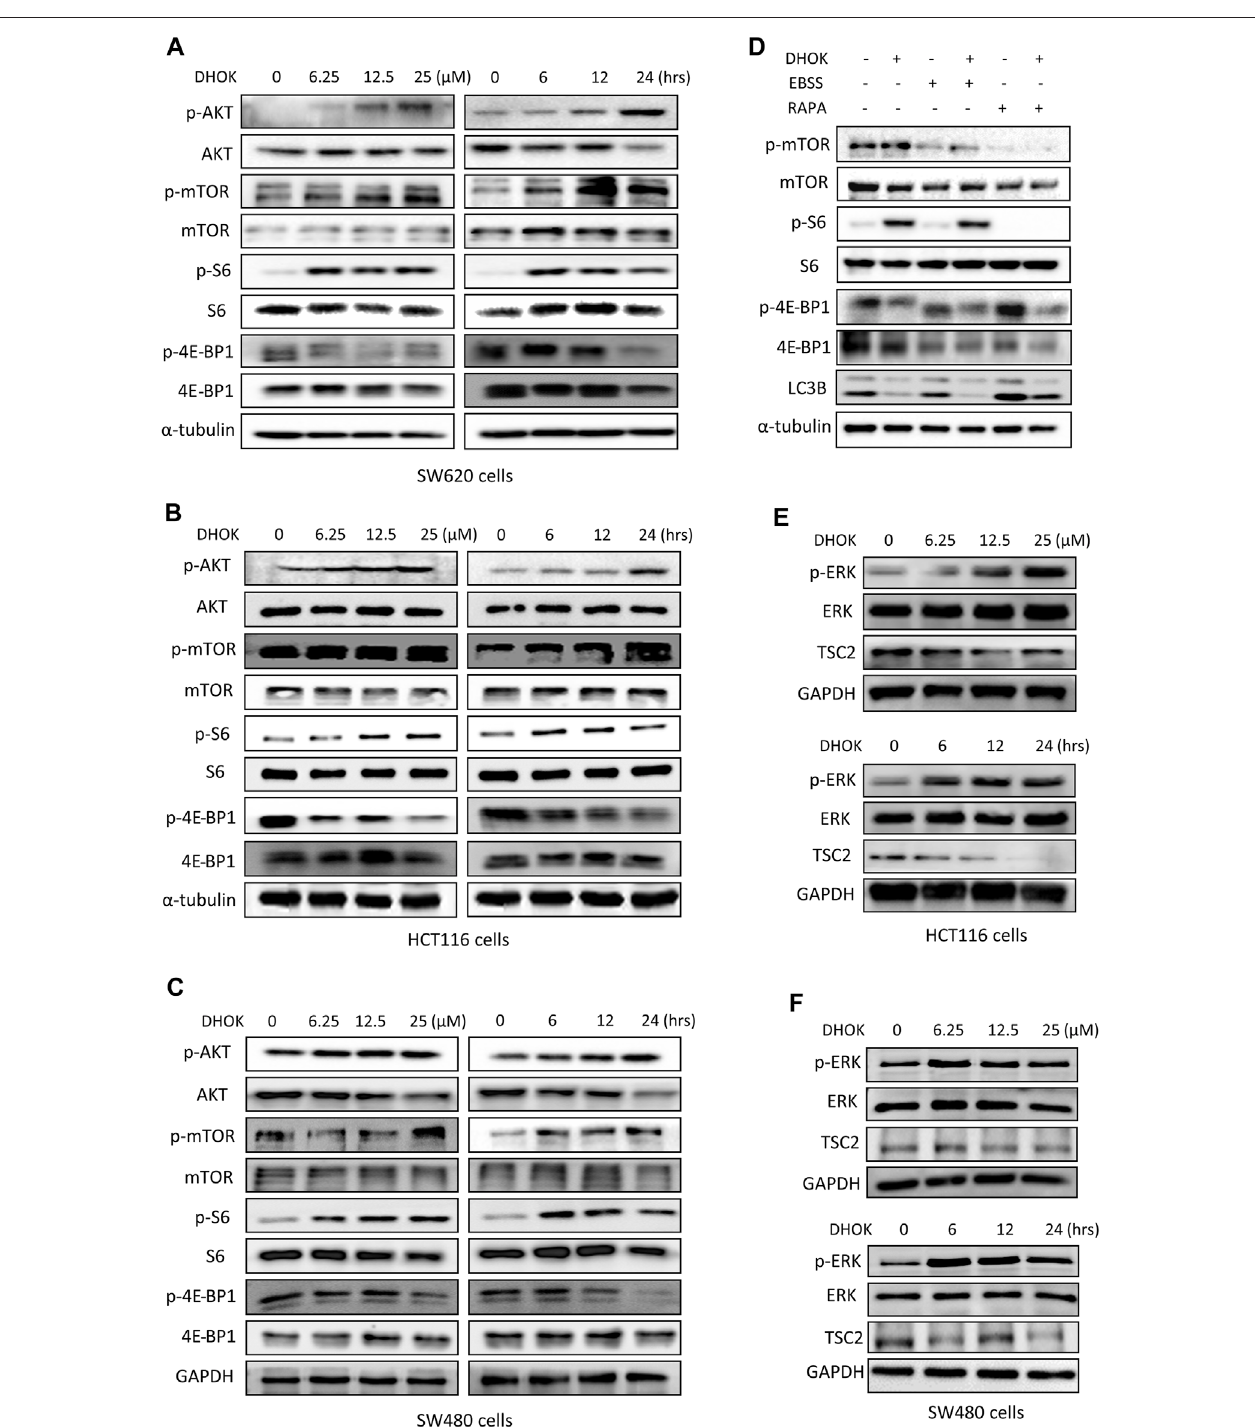
FIGURE 4 | DHOK inhibits autophagy through activation of mTOR signaling pathway. (A) SW620 cells were treated with different dosage of DHOK (6.25, 12.5, 25 μ M)fordifferenttime(6,12,24 h).ThencellswerelysedforwesternblottingtodetectthephosphorylationlevelsofAKT,mTOR,S6,and4E-BP1. α -tubulinorGAPDH served as loading control. (B,C) , as in (A) , HCT116 and SW480 cells were treated with DHOK and cells were harvested for western blotting analysis of the above phosphorylated proteins. (D) SW620 cells were pretreated with EBSS starvation or rapamycin (100 nM) for 2 h and then treated with DHOK (12.5 μ M, 24 h). And then cells were harvested for western blotting analysis of the phosphorylated mTOR, S6, 4EBP1, and LC3 levels. α -tubulin was used as loading control. (E,F) HCT116 andSW480cellsweretreatedwithdifferentdosageofDHOK(6.25,12.5,25 μ M)fordifferenttime(6,12,24 h).Andthencellswerelysedforwesternblottingtoexamine the phosphorylated-ERK, ERK, and TSC2 protein levels. GAPDH was used as loading control.